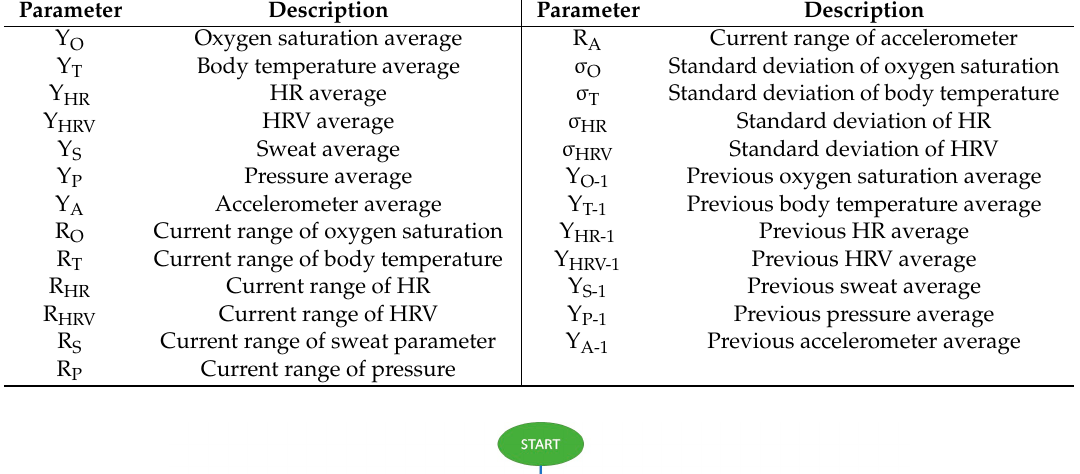
Table 3. Description of the parameters employed in the main algorithm and the algorithm for wellness range evaluation.